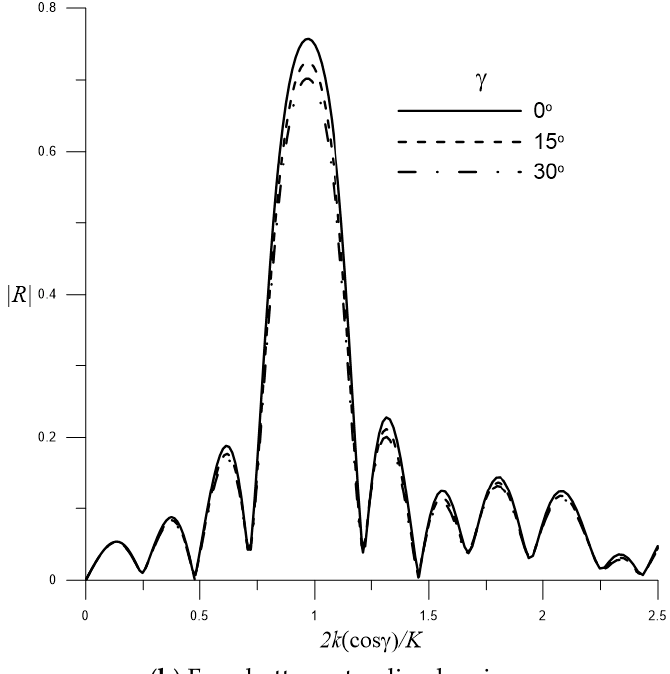
( b ) Four bottom ‐ standing barriers Figure 19. Reflection coefficient | R | varying against 2 k ( cos γ ) / K for the four ( a ) surface-piercing and Figure 19. Reflection coefficient | | R varying against 2 (cos )/ k K  for the four ( a ) surface ‐ ( b ) bottom-standing barriers with different oblique incident piercing and ( b ) bottom ‐ standing barriers with different oblique incident angles.